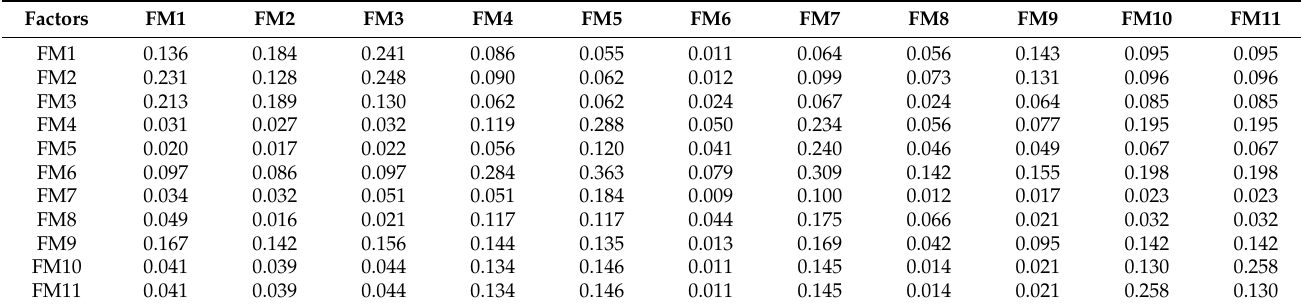
Table 5. The matrix of total relation.